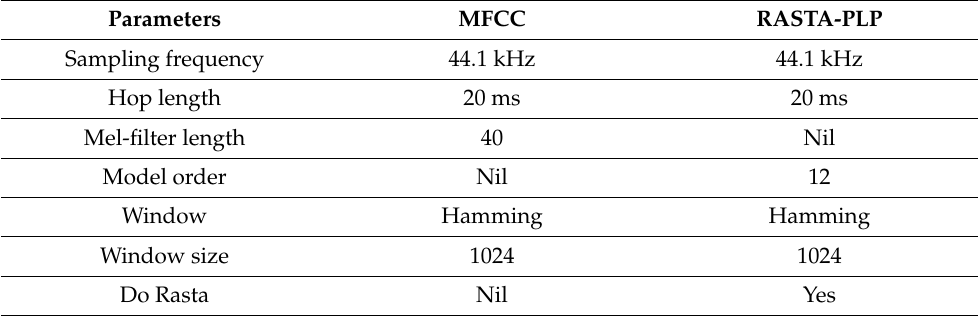
Table 3. Parameters used in feature extraction.